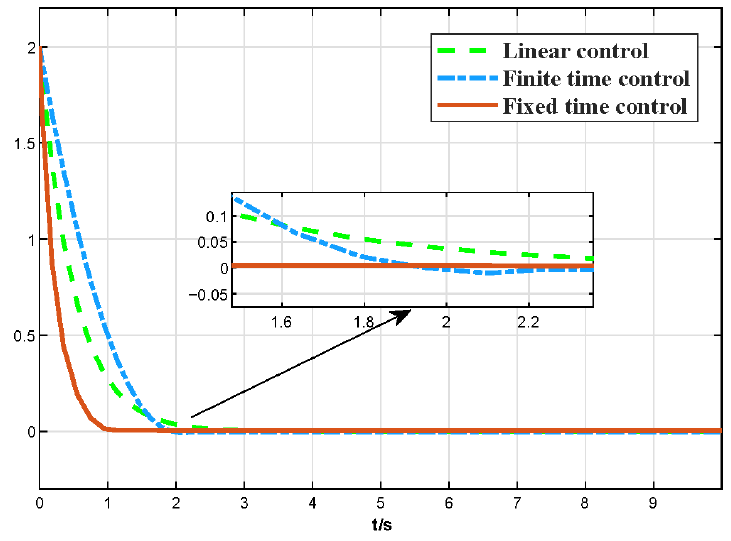
Figure 4. The comparative curve of fixed-time, finite-time, and linear control.